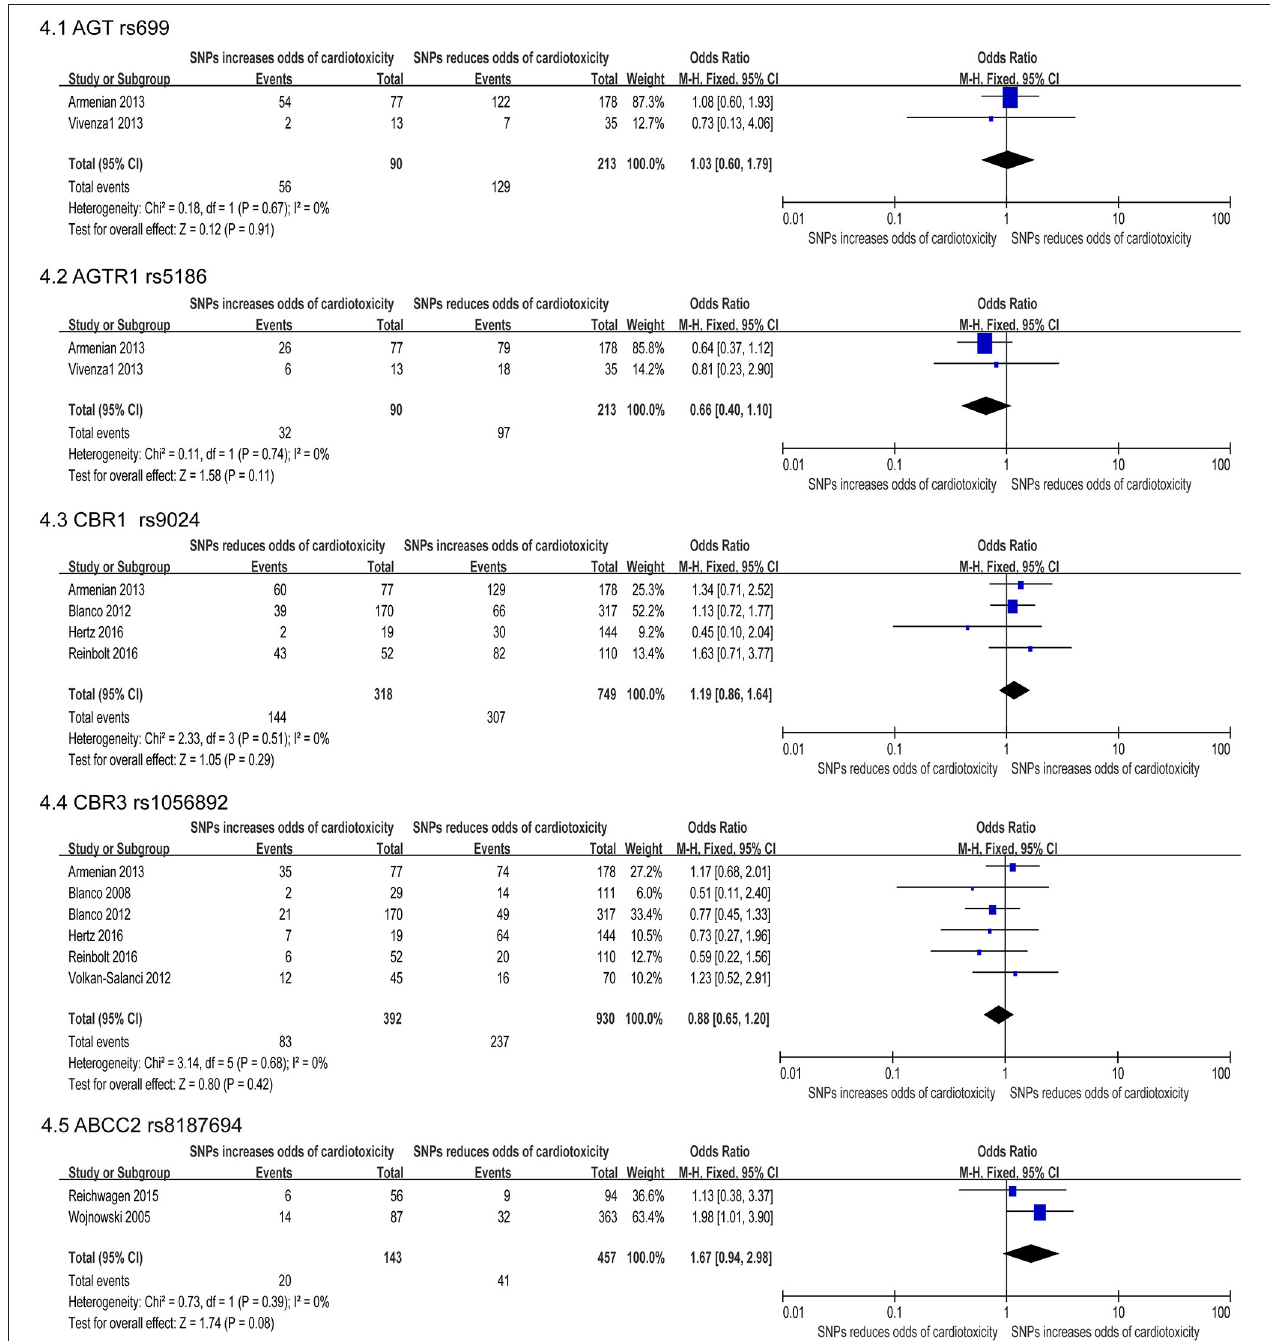
FIGURE 4 | Forest plot of meta-analysis for five SNPs. Five variants, AGT rs699, AGTR1 rs5186, CBR1 rs9024, CBR3 rs1056892, and ABCC2 rs8187694, are not statistically significant for chemotherapy induced cardiotoxicity.